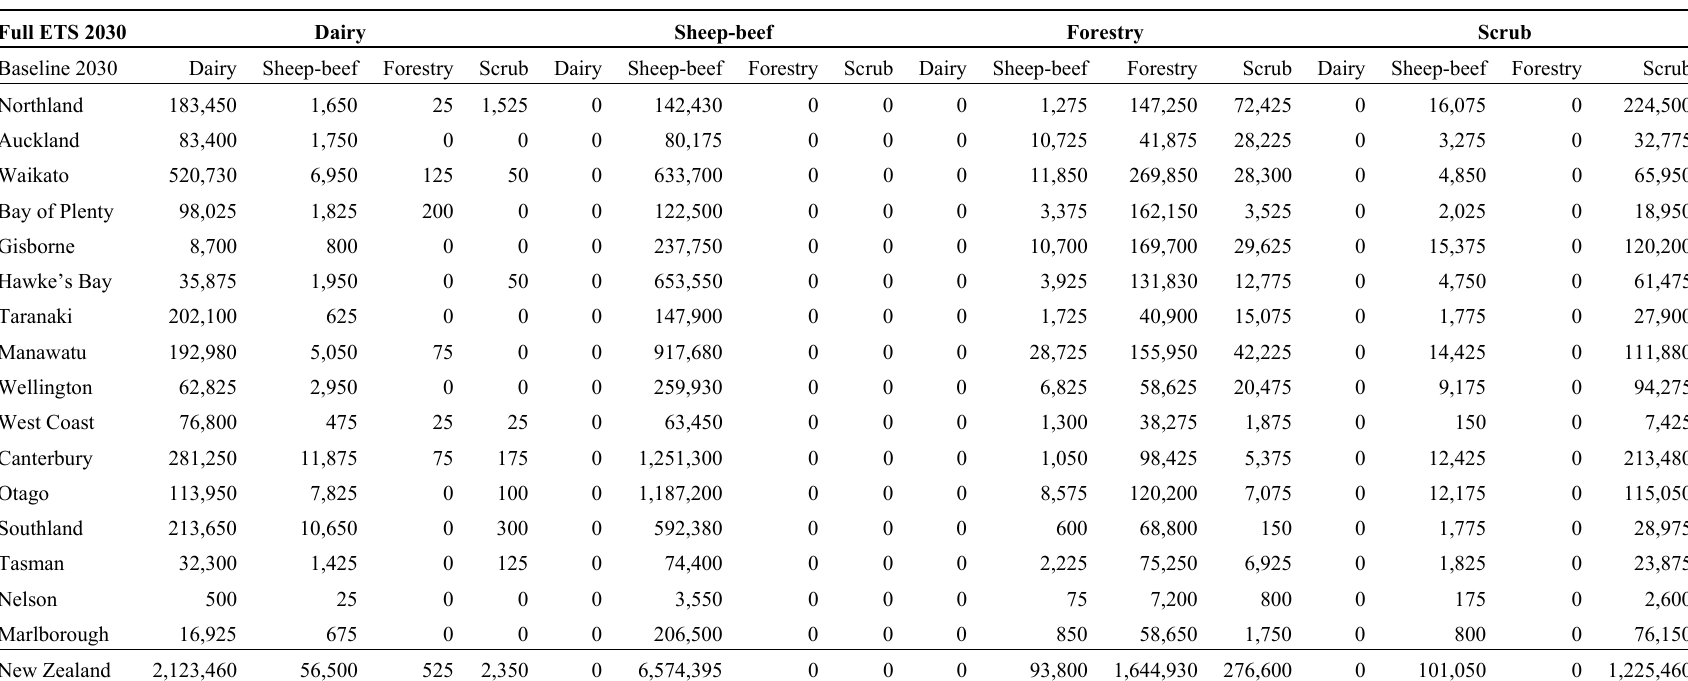
Table 2. Land-use differences (in hectares) in 2030 between the projected baseline and the full ETS scenarios by regional council. Full ETS 2030 Dairy